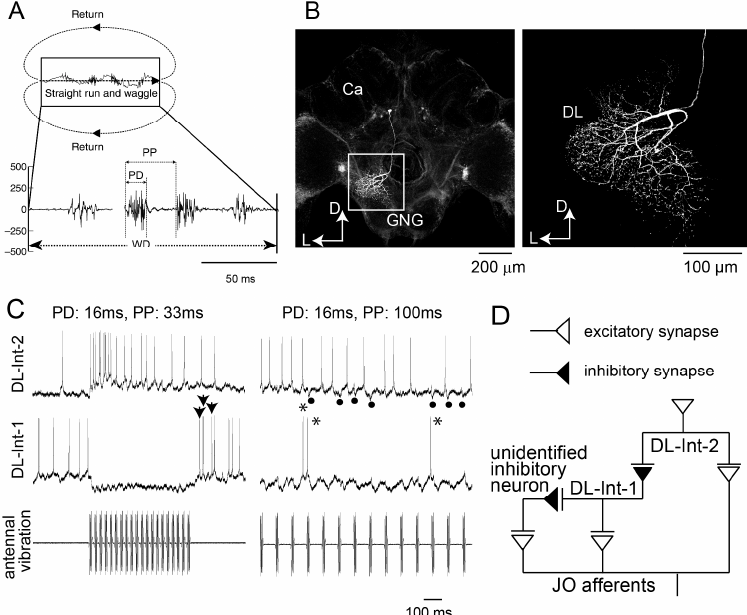
Figure 3. ( A ) (Top) Movement trajectory of a honeybee during the waggle dance. The dance consists of a waggle run and a return run. The distance to the flower source is encoded as the duration of the waggle run (WD) of the dance. (Bottom) Thoracic vibration velocities recorded during the waggle run. Intermittent vibration pulses occur with a constant pulse duration (PD) of about 16 ms and a pulse phase (PP) of about 33 ms. ( B ) Morphology of DL-Int-1. (Left) Gross image of the DL-Int-1. (Right) Magnified image of arborization in the dorsal lobe (DL) indicated by a square region in the left image. Ca: Calyx of mushroom body; GNG: Gnathal ganglion; D: Dorsal; L: Left. ( C ) Intracellular records of dorsal lobe interneurons 1 (DL-Int-1, middle) and 2 (DL-Int-2, top) in the antennal mechanosensory center of the honeybee in response to vibratory mechanical stimulation to an antenna (bottom). Left: When the PPs are shorter than 50 ms, the DL-Int-1 receives strong inhibition that allows no spikes during the pulse trains and exhibits a post-inhibitory rebound (PIR) excitation (arrowheads) upon the offset of the pulse train. DL-Int-2 exhibits elevated spiking activity during stimulation. Right: DL-Int-1 shows spikes (asterisks) intermittently during the inter-pulse interval phase when the PP of the stimulus is longer than 50 ms. Under these conditions, the DL-Int-2 often shows a lack of spikes with remarkable inhibitory postsynaptic potentials (IPSPs) (dots). ( D ) Putative neural circuits for processing the temporal structure of vibration signals. JO: Johnston’s organ. Modified from [34] with the permission of Company of Biologists for A, and from [48].